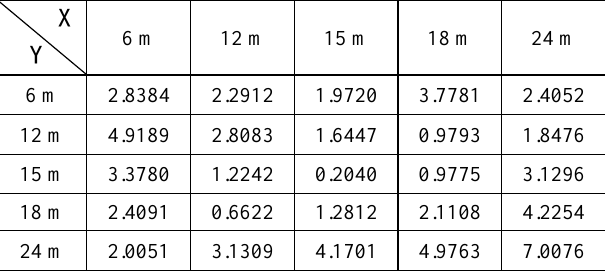
Table 3. Horizontal and vertical change at the same time, 25 points of the two norms.